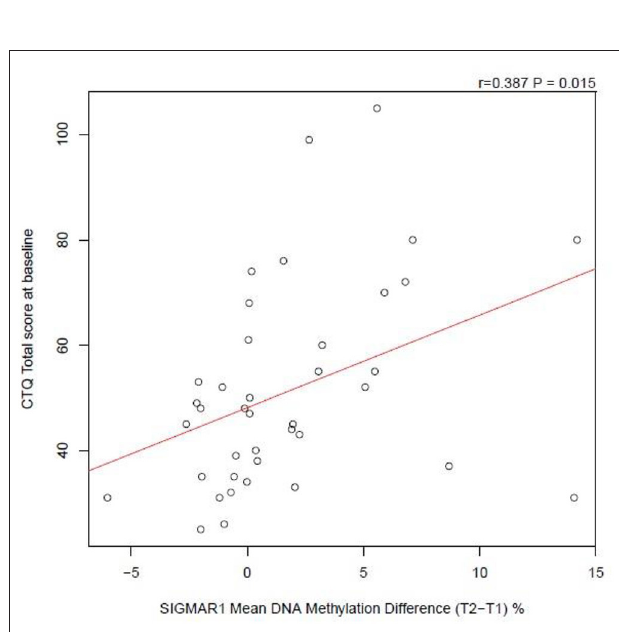
FIGURE 4 | Correlation analysis of CTQ total score at baseline against SIGMAR1 Mean DNA Methylation Difference (from T2 to